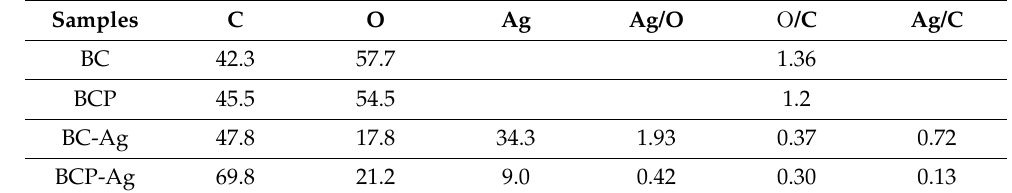
Table 2. XPS quantification data (at. %) determined from the high-resolution spectra.